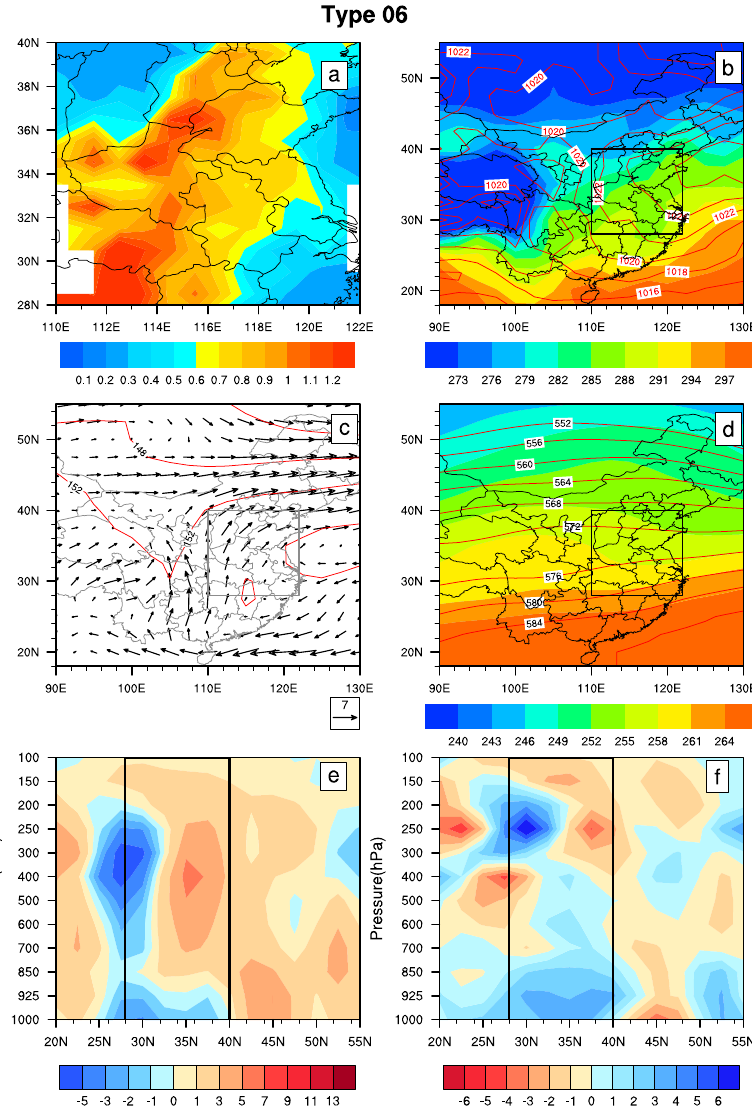
Figure 13. As in Fig. 8 but for Type 6